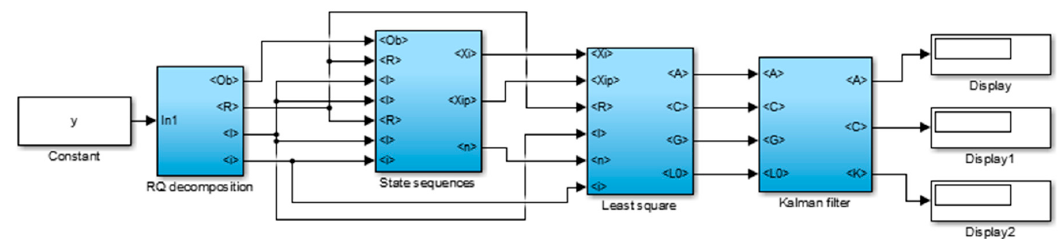
Figure 1. Diagram of the stochastic subspace identification (SSI)-DATA algorithm.